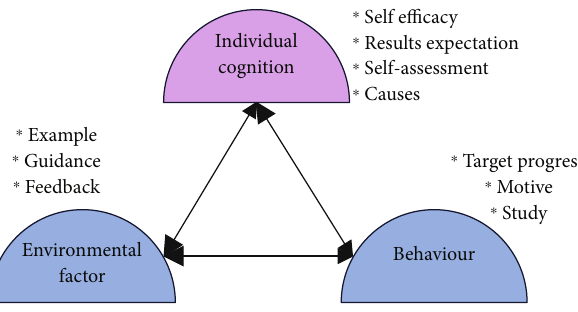
Figure 2: The “ ternary interactive determinism ”